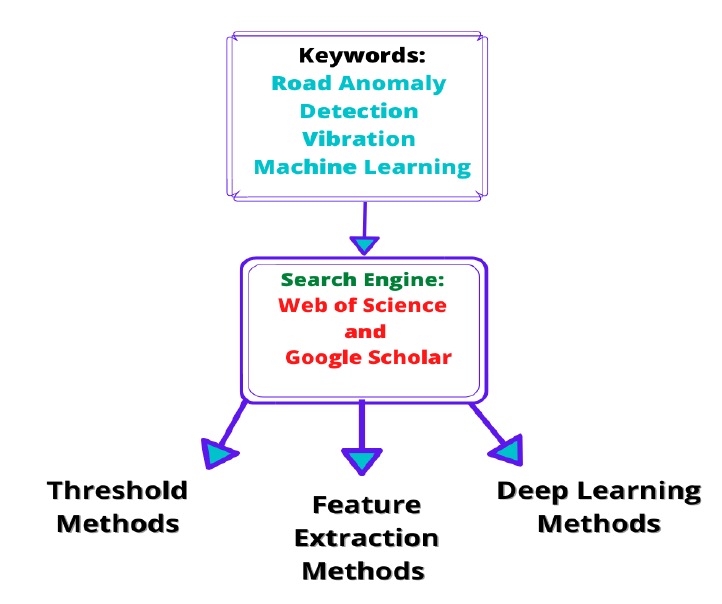
Figure 1. Schematic representation of the search process performed for this narrative review that focuses on vibration-based techniques used for the detection and classification of anomalies on the road surface.